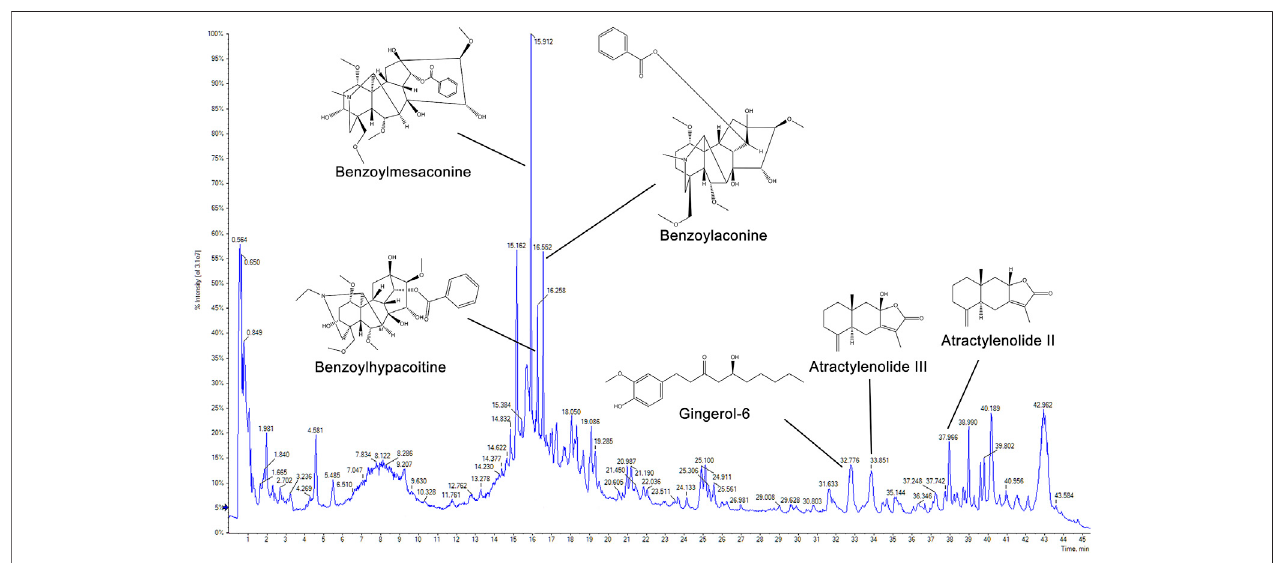
FIGURE 1 | Chromatogram of Zhen-wu-tang (ZWT) by UPLC-Q-TOF-MS. The chemical structures of six marker ingredients are